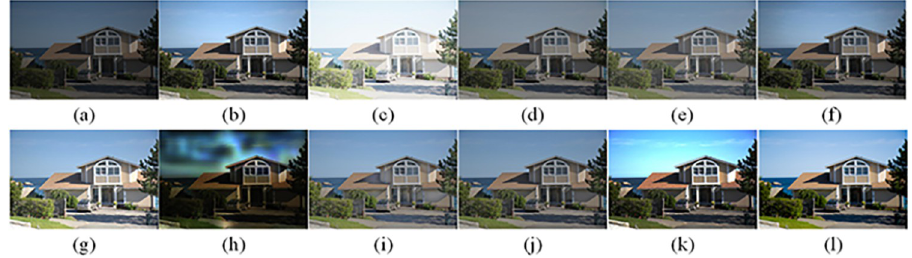
Fig 16. Comparisons of the ten algorithms in enhancing low-light image 6. (a) low-light image (b) AGCWD (c) Al- Ameen (d) BHE2PL (e) BIMEF (f) BPDHE (g) LIME (h) MSRCR (i) NPEA (j) SRIE (k) OURS (l) Normal light image.